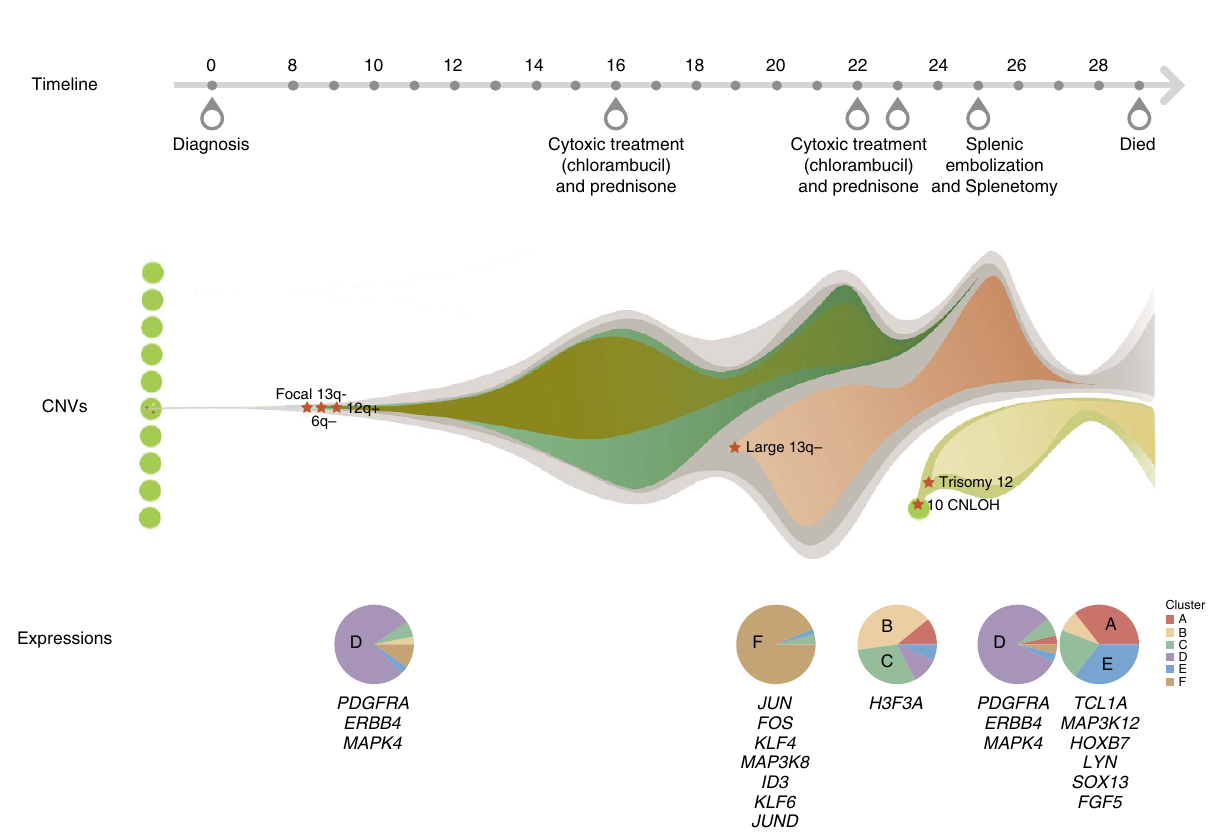
expressed in B cells and mediates response from the BCR. LYN is located on chromosome 12, and the trisomy 12 event may